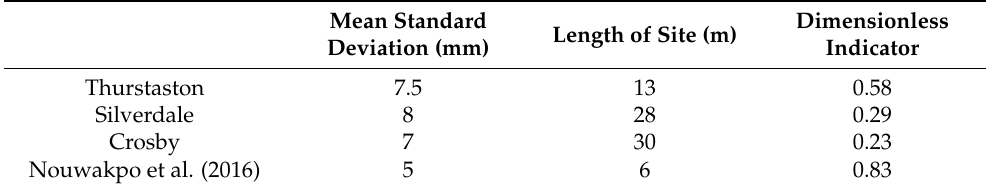
Table 3. Calculation of dimensionless indictor based on standard deviation from the three study sites compared with data from Nouwakpo et al. (2016)